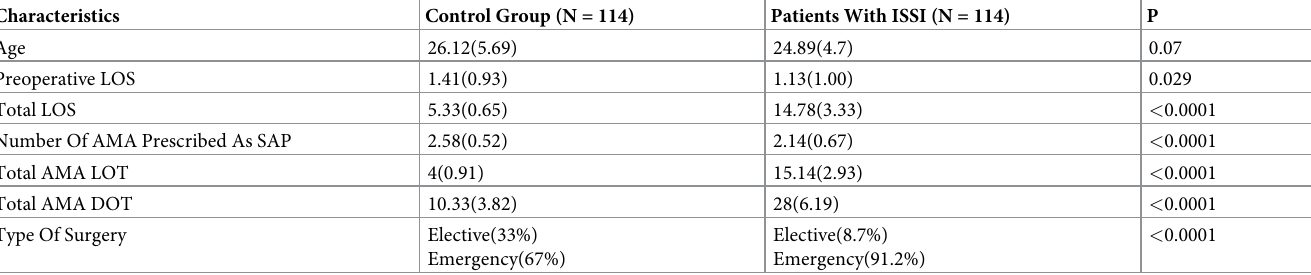
Table 1: Data are presented as mean(SD) or percentage. AMA: Antimicrobial agents; SAP: Surgical antimicrobial prophylaxis; LOS; Length of hospital stay; LOT: Length of (antimicrobial) Therapy; DOT: Days of (antimicrobial)